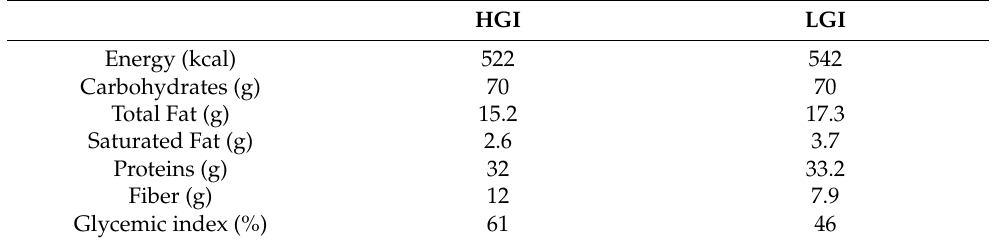
Table 3. Energy intake, macronutrients, and glycemic index of the two test meals.